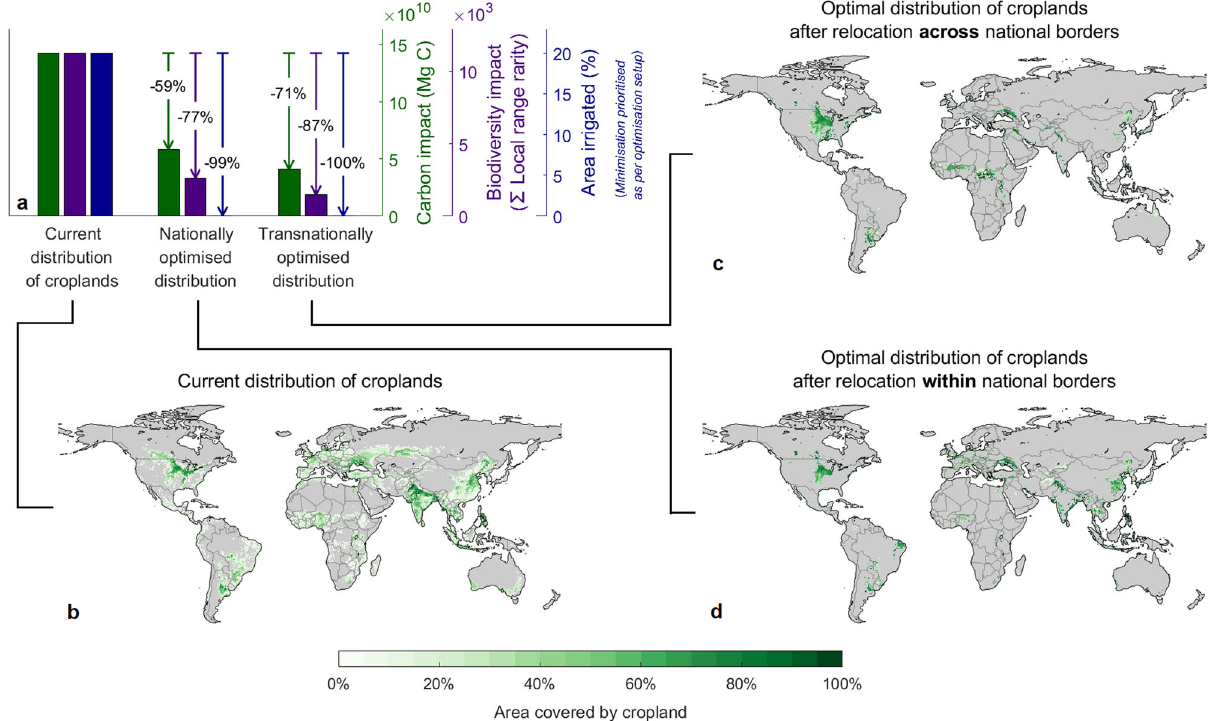
Fig. 1 Current and environmentally optimal distributions of global croplands. The estimated reduction potentials in a are based on an optimal trade-off between carbon and biodiversity impacts (see the “ Methods ” section). Potential yield data used here are based on current climatic conditions and assume high-input crop management and rainfed water supply, so that relocated areas are, by design of the approach, not irrigated. The global production levels of individual crops for optimally distributed areas are identical to current levels; in the scenario of national relocation, this is additionally the case for national production levels. For visualisation purposes, in b – d , the 25 crops were grouped together; maps of the optimal distribution of individual crops for across- and within-border relocation are shown in Supplementary Movie